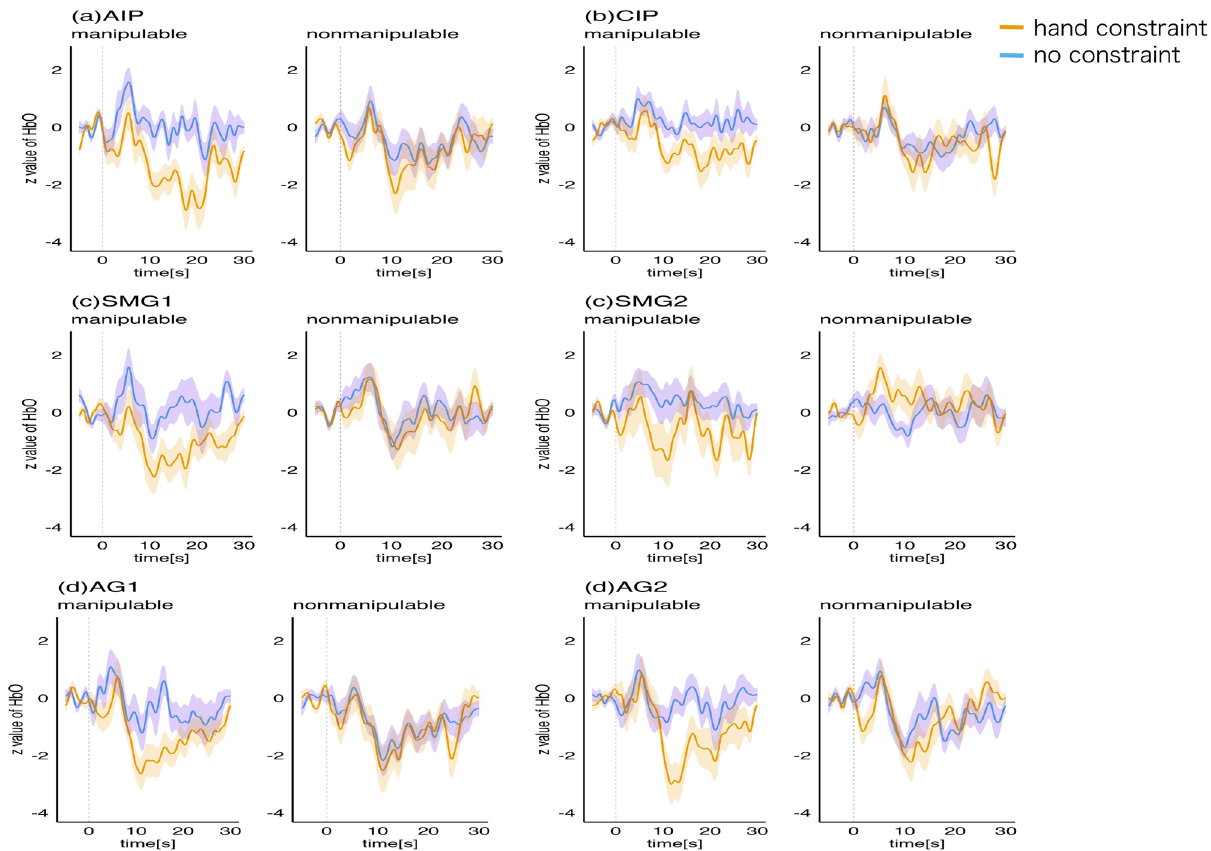
Figure 4. The averaged waveforms of hemodynamic responses in the LIPS and LIPL. The waveforms represent the mean z scores of the target task in each second. The standard error of the mean is illustrated as a shaded area around the waveform in corresponding colors. The task started at 0 s (vertical break